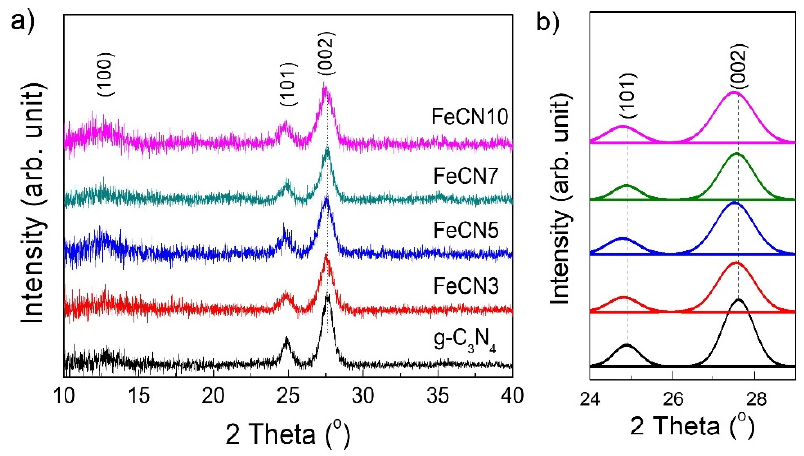
Figure 2. ( a ) X-ray diffraction (XRD) patterns of Fe-doped g-C 3 N 4 nanosheets with different Fe concentrations; ( b ) The comparison of (101) and (002) XRD peak position.